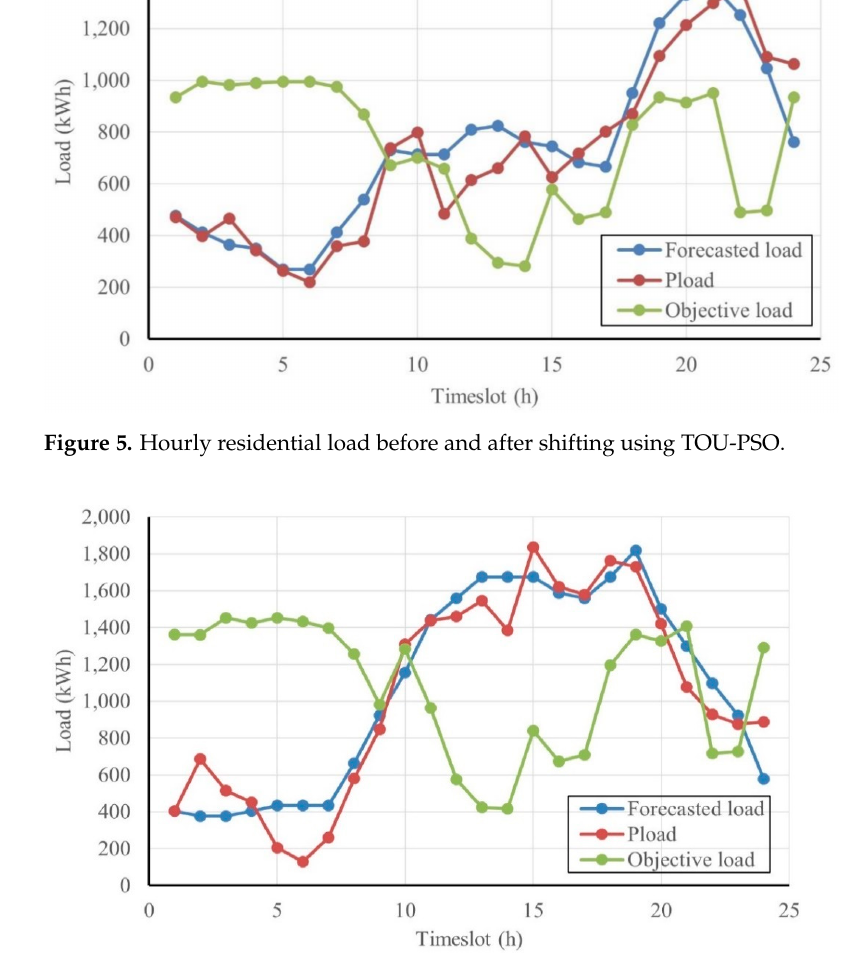
Figure 7. Hourly industrial load before and after shifting using TOU-PSO. Figure 8. Hourly residential load before and after shifting using TOU-SBY.